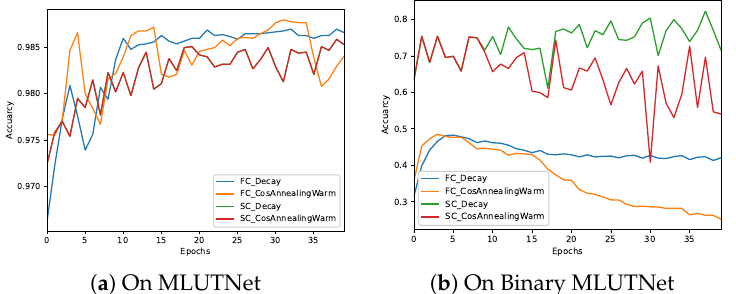
Figure 9. Comparison of fully connection and sparsely connection.